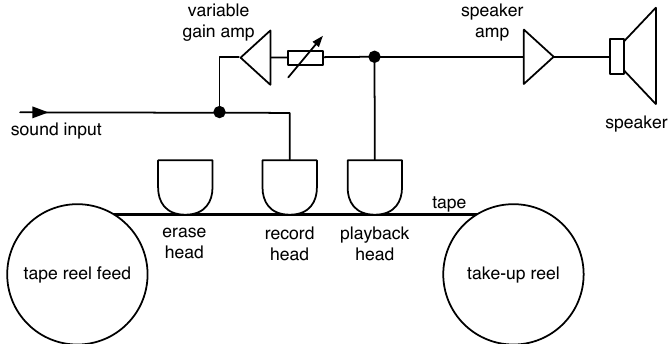
Figure 4. Traditional tape echo: the signal picked up by the playback head feeds back to the record